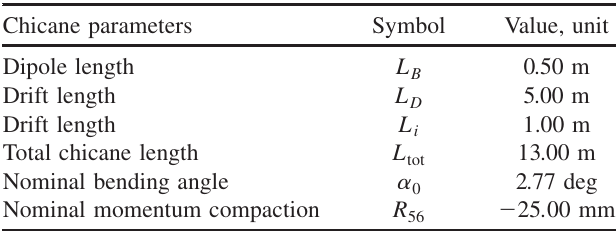
TABLE II. Parameter values for chicane shown in Fig. 10.